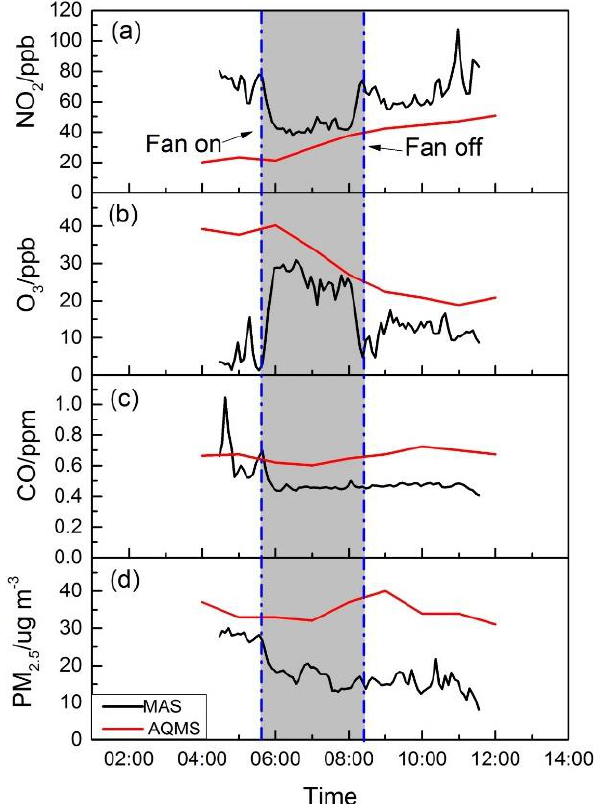
Figure 10. The pollutants’ concentrations inside WHC from MAS and at the Central AQMS. ( a ) Time series for NO 2 ; ( b ) time series for O 3 ; ( c ) time series for CO; ( d ) time series for PM 2.5 .